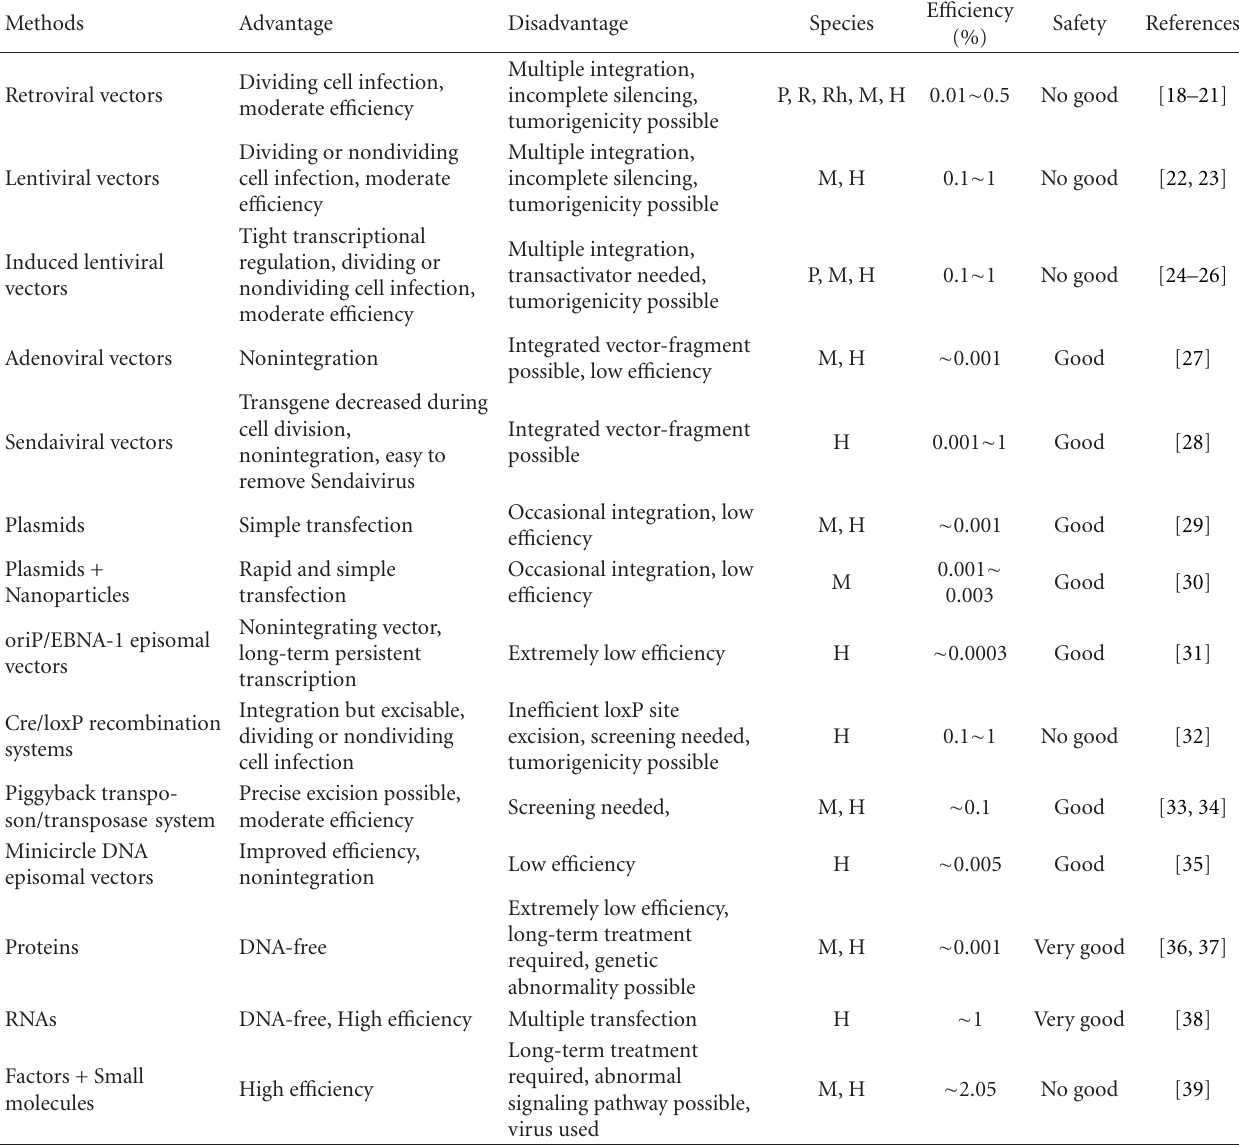
Table 1: Methods of e ffi cient and safe iPSCs generation for clinical